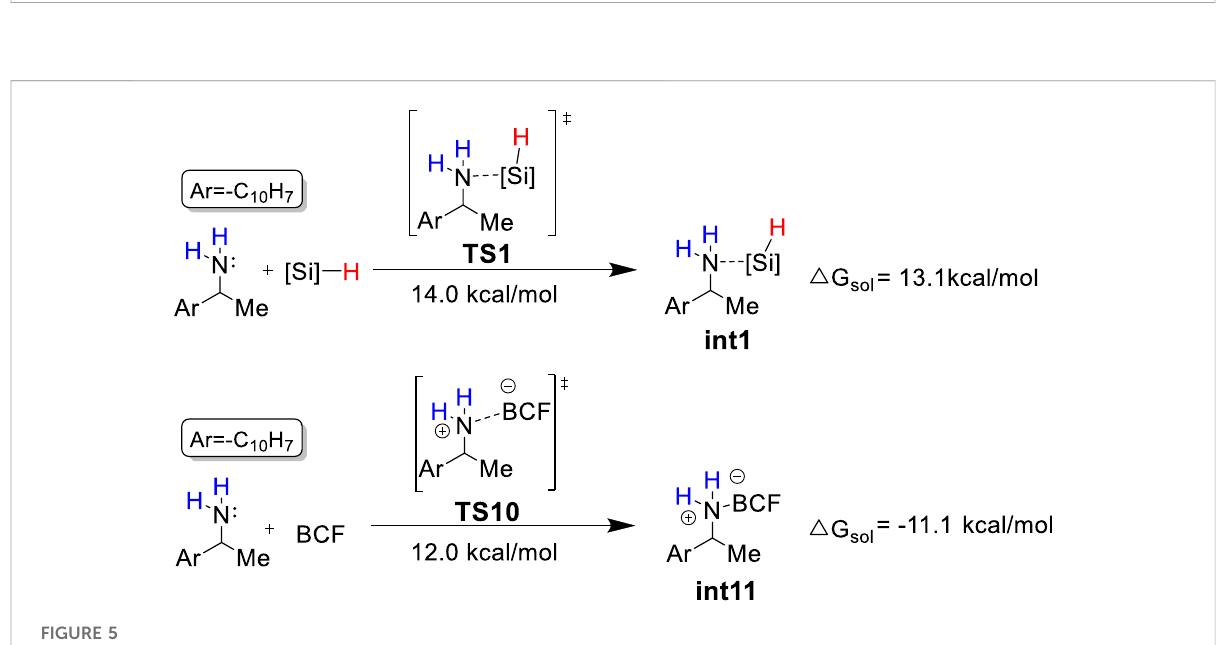
Competition between the formation of int1 and int11 . BCF = B(C 6 F 5 ) 3 ; [Si] = − PhSiH 2